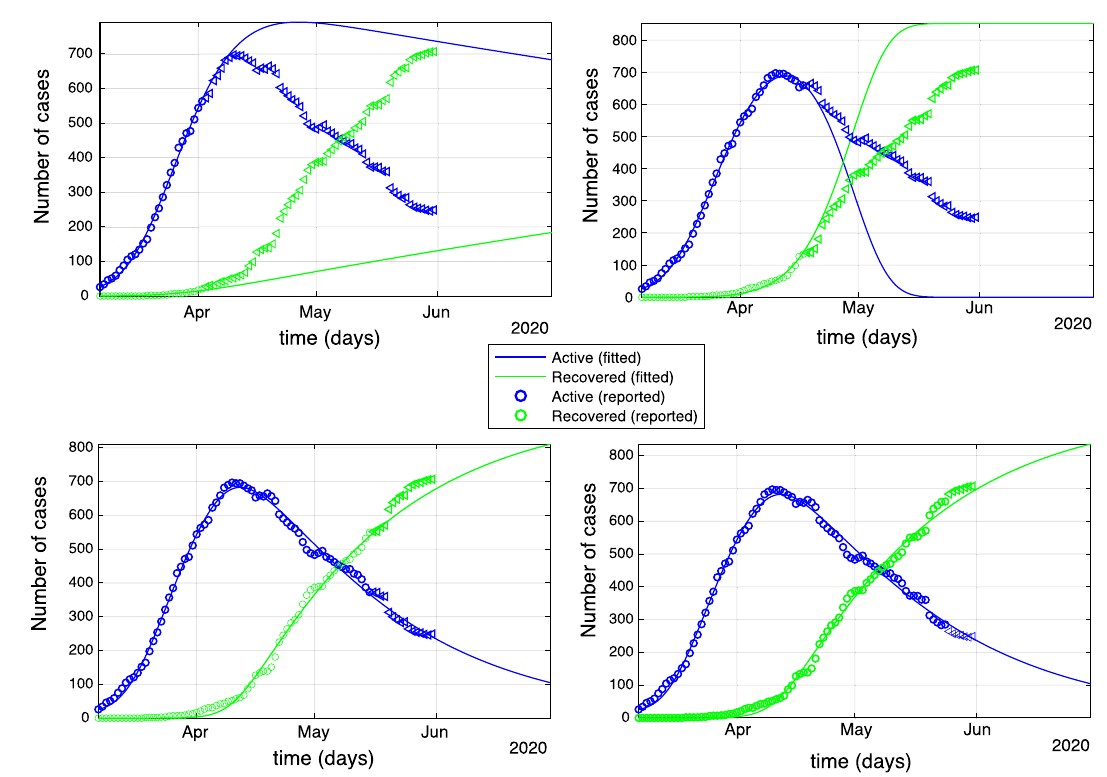
Figure 2. Predictions obtained after fitting (6) for the number of active cases (green) and recovered cases (blue) until the end of the observation period. Parameter estimation was performed by subsampling the data until (top left) 2/4/2020, (top right), 15/4/2020, (bottom left) 15/05/2020 (bottom right) 24/5/2020.The relative error equals 0.4%, 0.2%, 0.3%, 0.3% for the recovered and 18%, 5.8%, 0.16%, 0.1% for the active